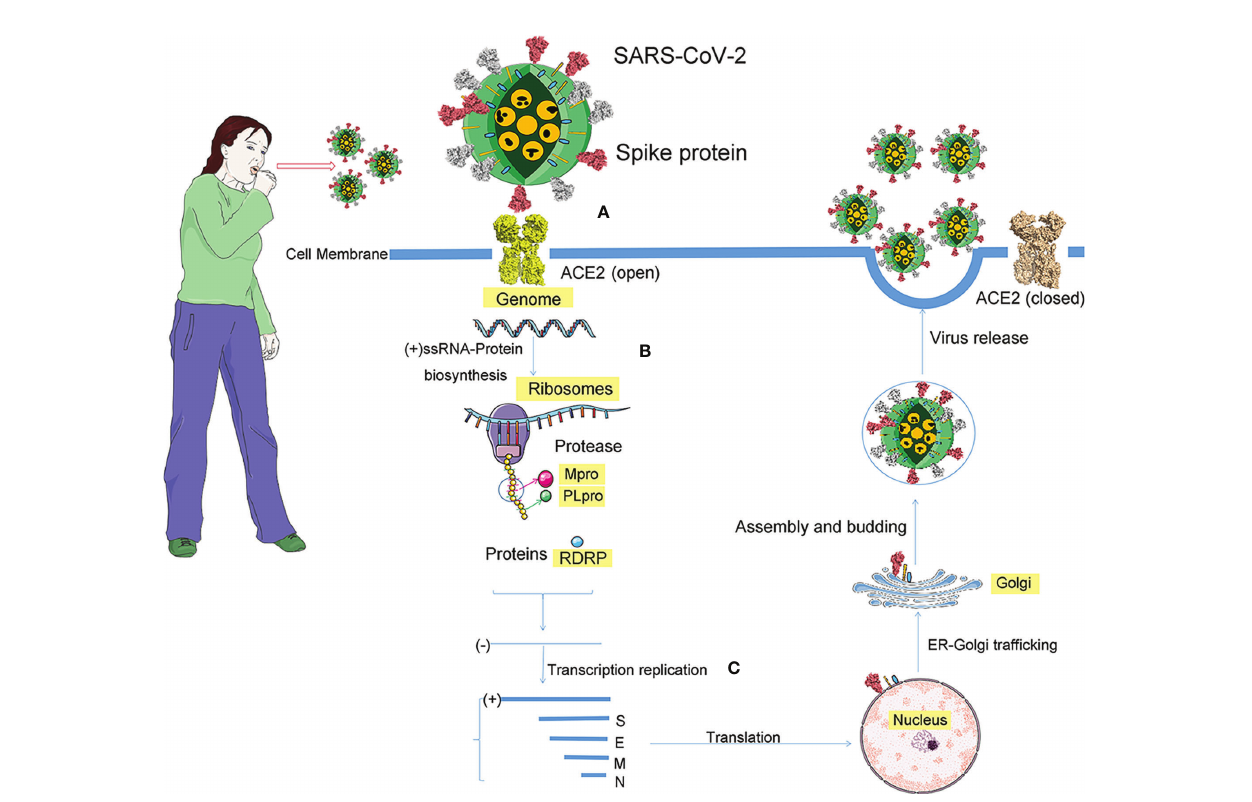
FIGURE 5 | The process of SARS-CoV-2 infection. After coughing, the infected patient will spread virus particles into the air, and people will be exposed to these virus particles. If these virions reach the cell, the infection process begins. The infection is divided into three steps. (A) For SARS-CoV-2, the receptor of spike protein is ACE2. The pink ball is the spike protein. (B) After entering the cell, the positive genomic RNA attaches to the host ribosome, translating two large coterminal polyproteins. These proteins are treated by proteolysis into components that package new virions. The two proteases involved in this proteolysis process are the major coronavirus protease (Mpro) and the papain-like protease (PLpro). (C) RNA-dependent RNA polymerase (RdRp), a replicase encoded by SARS-CoV-2, replicates the RNA